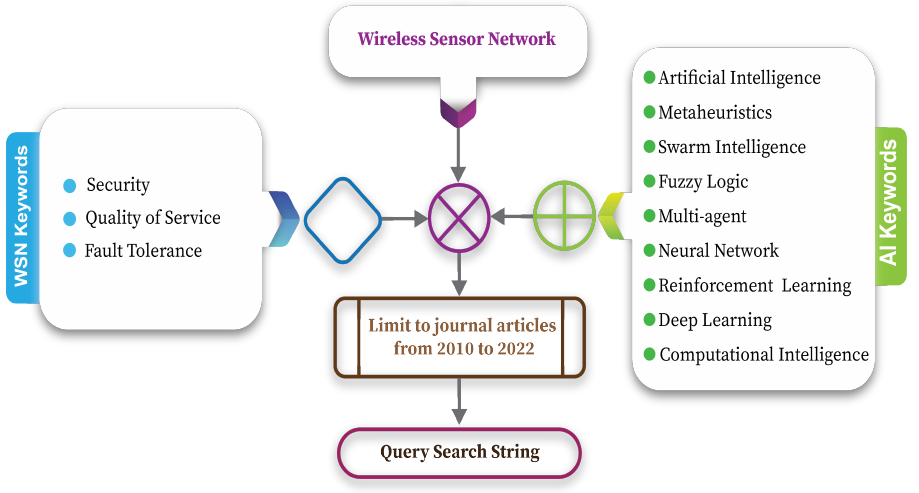
Figure 2. Diagram: search query